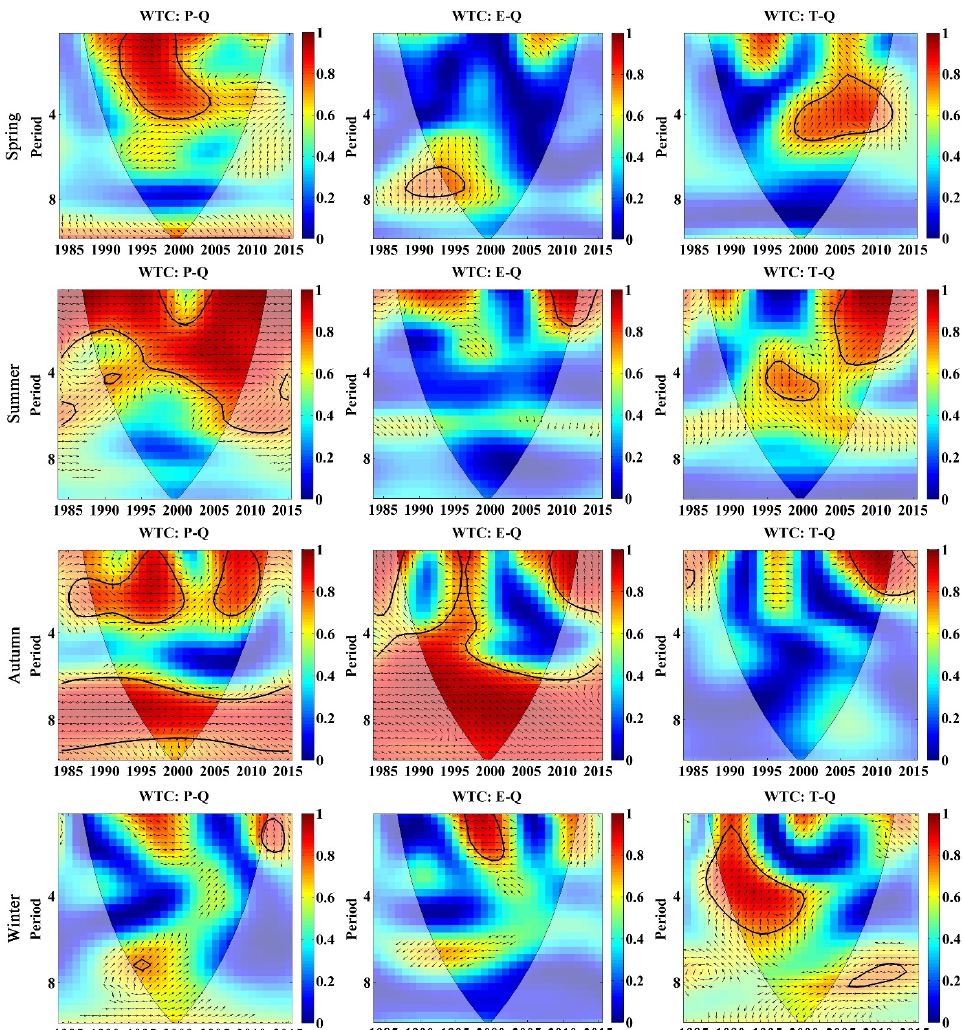
Figure 15. WTC between runoff and rainfall, evaporation and temperature on monthly scale. The thick black contour designates the 5% significance level against red noise and the cone of influence (COI) where edge effects might distort the picture is shown as a lighter shade.Arrows denote rela- tive phase difference: The arrows from left to right indicate that the influencing factors and runoff are in the same phase, which implies a positive correlation; the arrows from right to left indicate an inverse phase, which implies a negative correlation; the downward arrows indicate that the influ- ence factor is 90° ahead of the runoff change and the upward arrows indicate that the influence factor is 90° lagging the runoff.